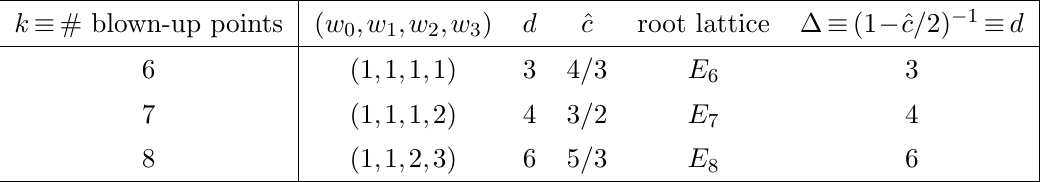
Table 2 . Index-1 Fano surfaces whose anti-canonical model is a weighted projective hypersurface. ^ c is the CY dimension of the associated algebra. (cid:1) is the Coulomb branch dimension of the corresponding rank-1 SCFT, while the root lattice described in [69] section 8.2 (see (cid:12)fth column) dictates its (cid:13)avor symmetry. The root lattice in the (cid:12)fth column corresponds to the Kodaira type of the associated algebra A (cf. third row of table